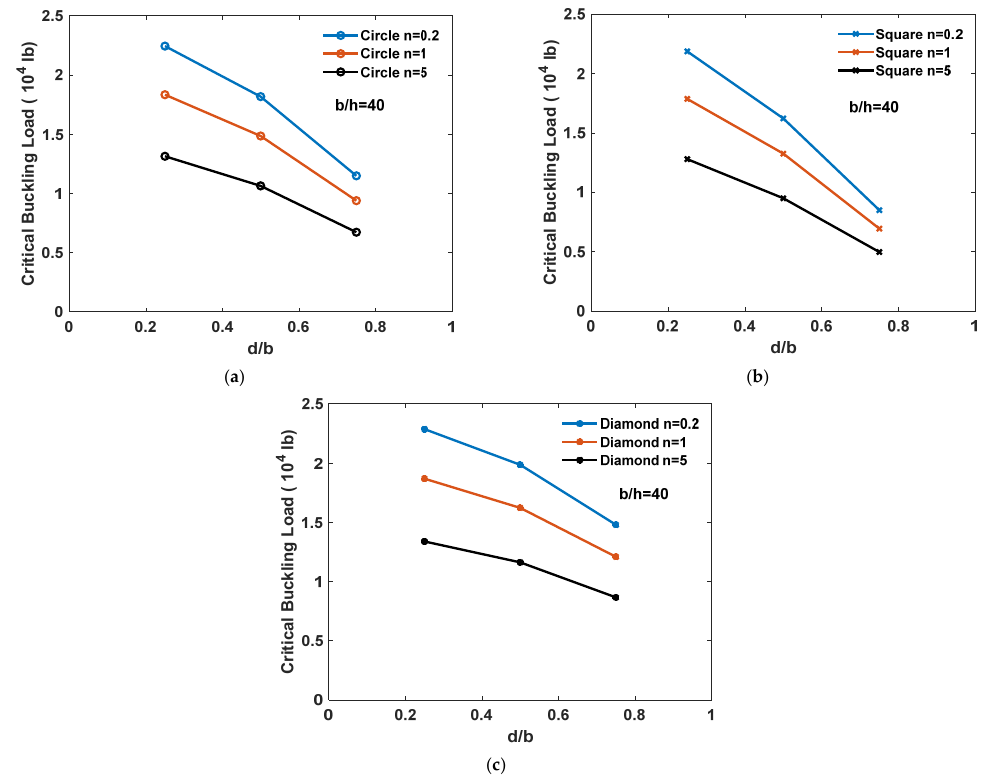
Figure 14. The variation of the opening aspect ratio on the critical buckling load for ( a ) circle, ( b ) square, and ( c ) diamond openings for an aspect ratio b/h = 40. Figure 15 shows the aspect ratio variation on the normalized stress ratio of the FGM plate. The normalized stress ratio is obtained by converting the buckling load to stress and dividing it by the material’s yield stress. The yield stress of the FGM is acquired us- ing the 0.2% offset method. The results show that the power coefficient (n) has no effect on the normalized stress for various aspect ratios, opening shapes, and dimensions. For instance, the normalized stress ratio of an FGM plate with a circle opening, a d/b = 0.2, and a b/h = 10 is 0.858 for n = 0.2, n = 1, and n = 5. Figure 16 shows the variation of the opening aspect ratio on the normalized stress ratio of the FGM plate. It is seen that as the aspect ratios increase, the normalized stress ratio decreases, indicating that the buckling stress becomes significantly smaller than the yield stress of the FGM plate. Moreover, the variation aspect ratio of the plate greatly affects the normalized stress ratio as compared to the variation of the opening aspect ratio.